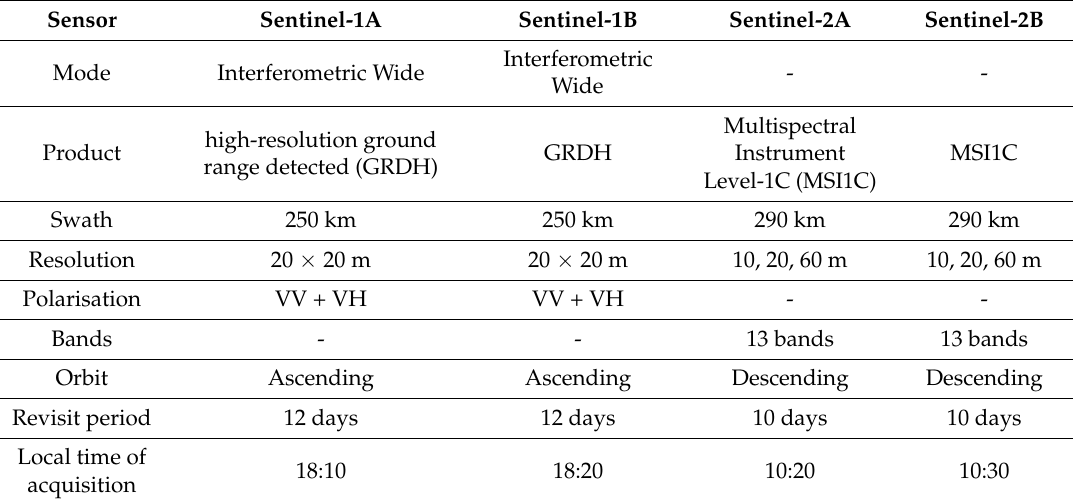
Table 1. Sensor characteristics and data acquisition